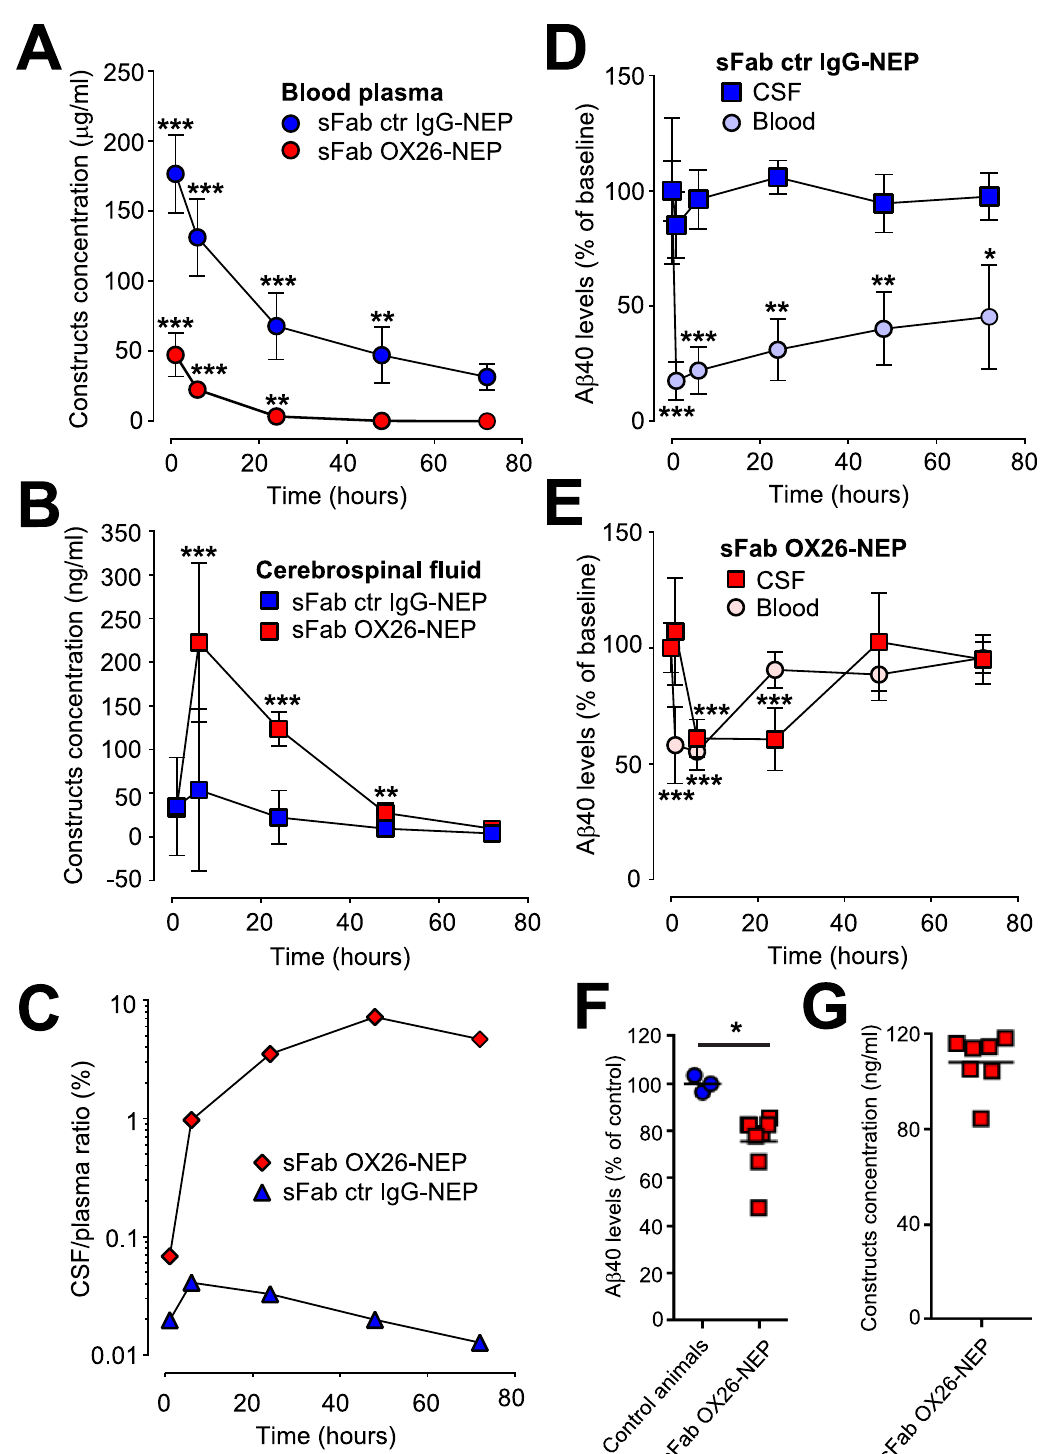
Fig 2. Delivery of NEP to the brain results in CSF A β 40 reduction. Pharmacokinetic, brain uptake and NEP activity of a one- armed OX26 (red) and control IgG (blue) NEP fusion protein in cisterna magna cannulated rats after a 10mg/kg single i.v. injection. Changes in (A) plasma and (B) CSF concentrations of sFab OX26-NEP (red circles and red squares) and sFab ctr IgG-NEP (blue circles & blue squares) following i.v. injection. Shown are average concentrations per treatment group (N = 6) and the SD. Two tailed unpaired t-tests based on the corresponding 72 h concentrations were applied, ��� p � 0.001 and ��